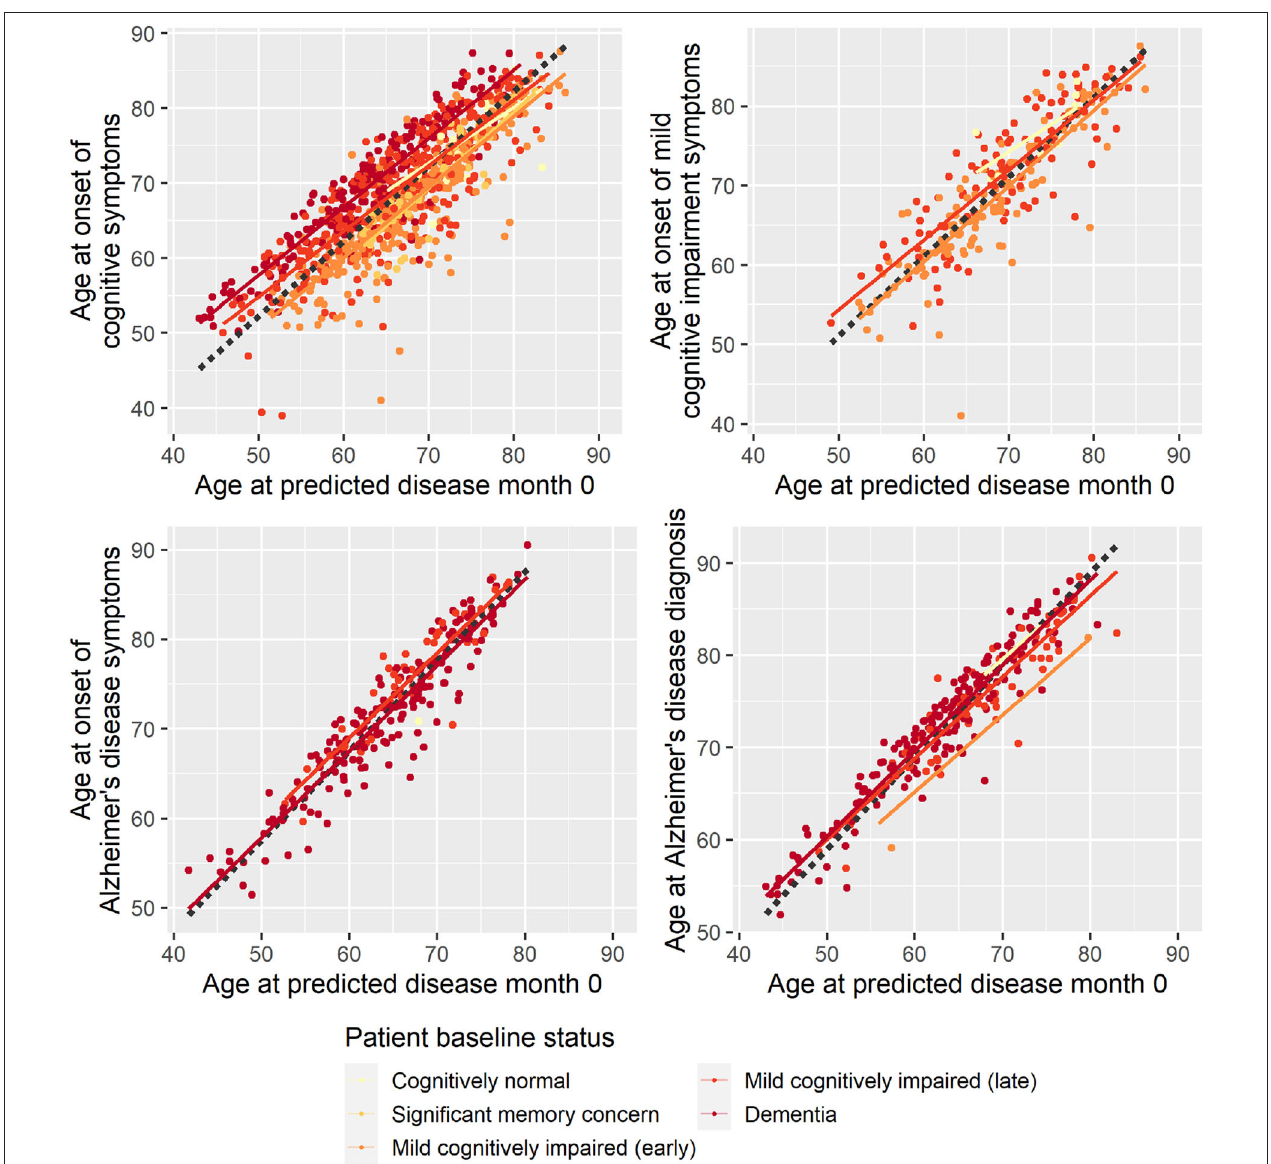
FIGURE 2 | Reported age at onset of cognitive symptoms (top left), cognitive impairment symptoms (top right), Alzheimer disease symptoms (bottom left), and Alzheimer disease diagnosis (bottom right) as a function of age at predicted disease month 0. Dotted lines represent the best-fitting least-squares estimated lines with slope